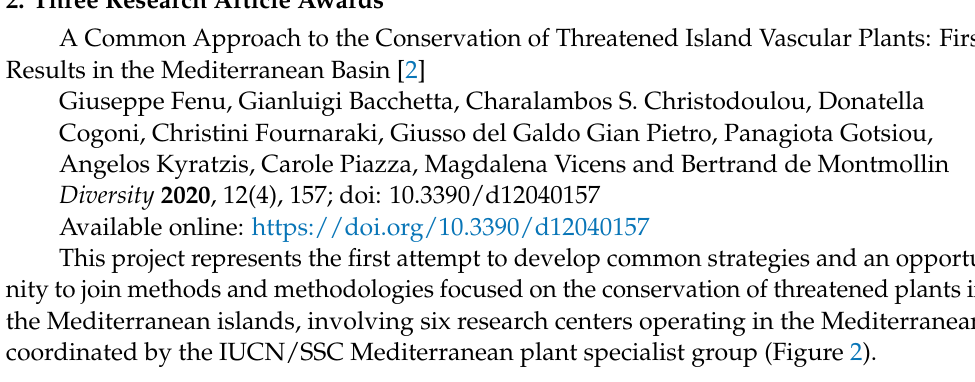
Figure 1. Benton N. Taylor, Ellen L. Simms and Kimberly J. Komatsu (from left to right).